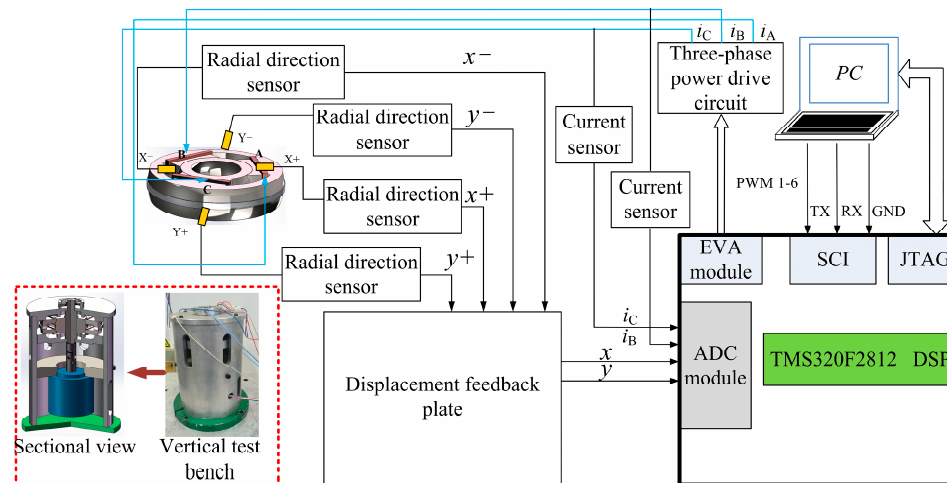
Figure 7. Hardware block diagram.